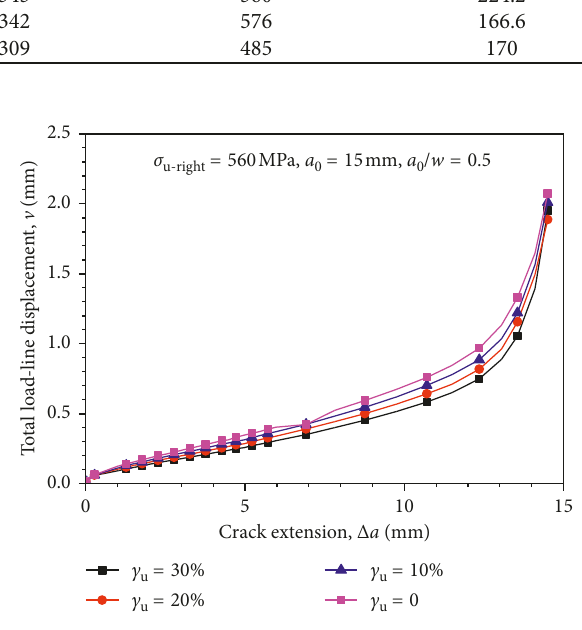
Figure 6: Applied displacement-crack extension curve of ultimate tensile strength mismatch specimen.